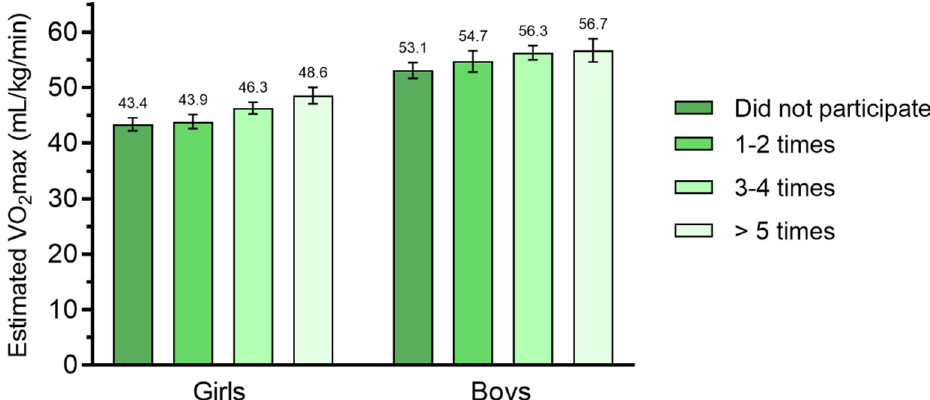
Figure 1. Adjusted mean CVF between adolescents participating in organised sports grouped into weekly participation rate. Values were adjusted for BMI, MVPA and wear time. Error bars represent 95% confidence interval.